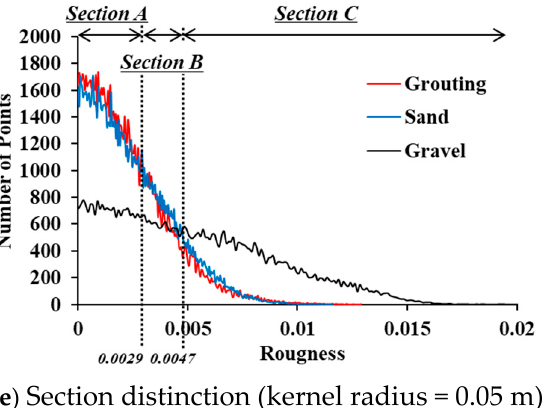
duced to 0.05 m, the protrusions of the gravel sample are more clearly distinguished from